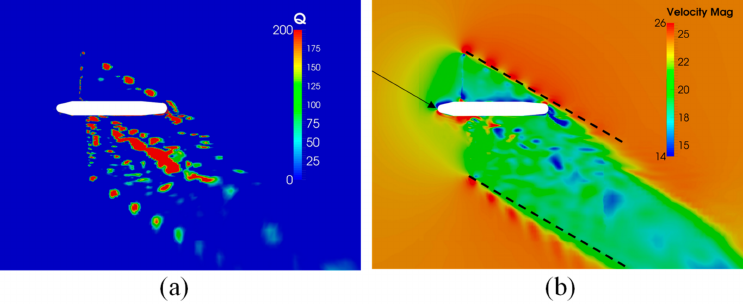
Figure 13. Contours of ( a ) Q-criteria field and ( b ) velocity magnitude field in horizontal plane at inflow speed of 24 m/s, TSR =